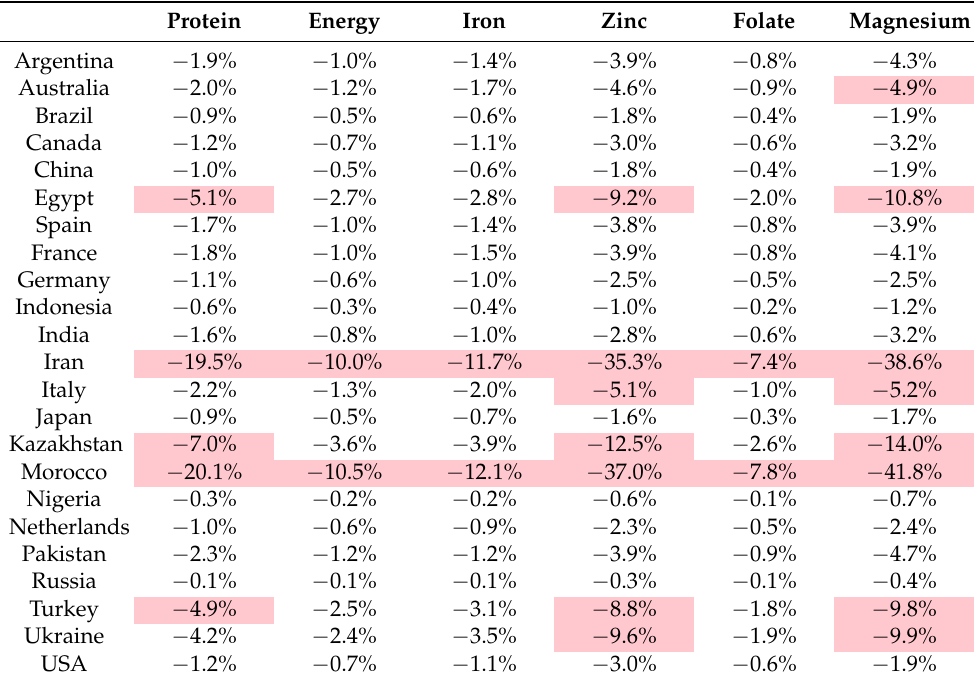
Table 5. NAR values, productivity & export restriction-induced shocks (Scenario YQ) *.